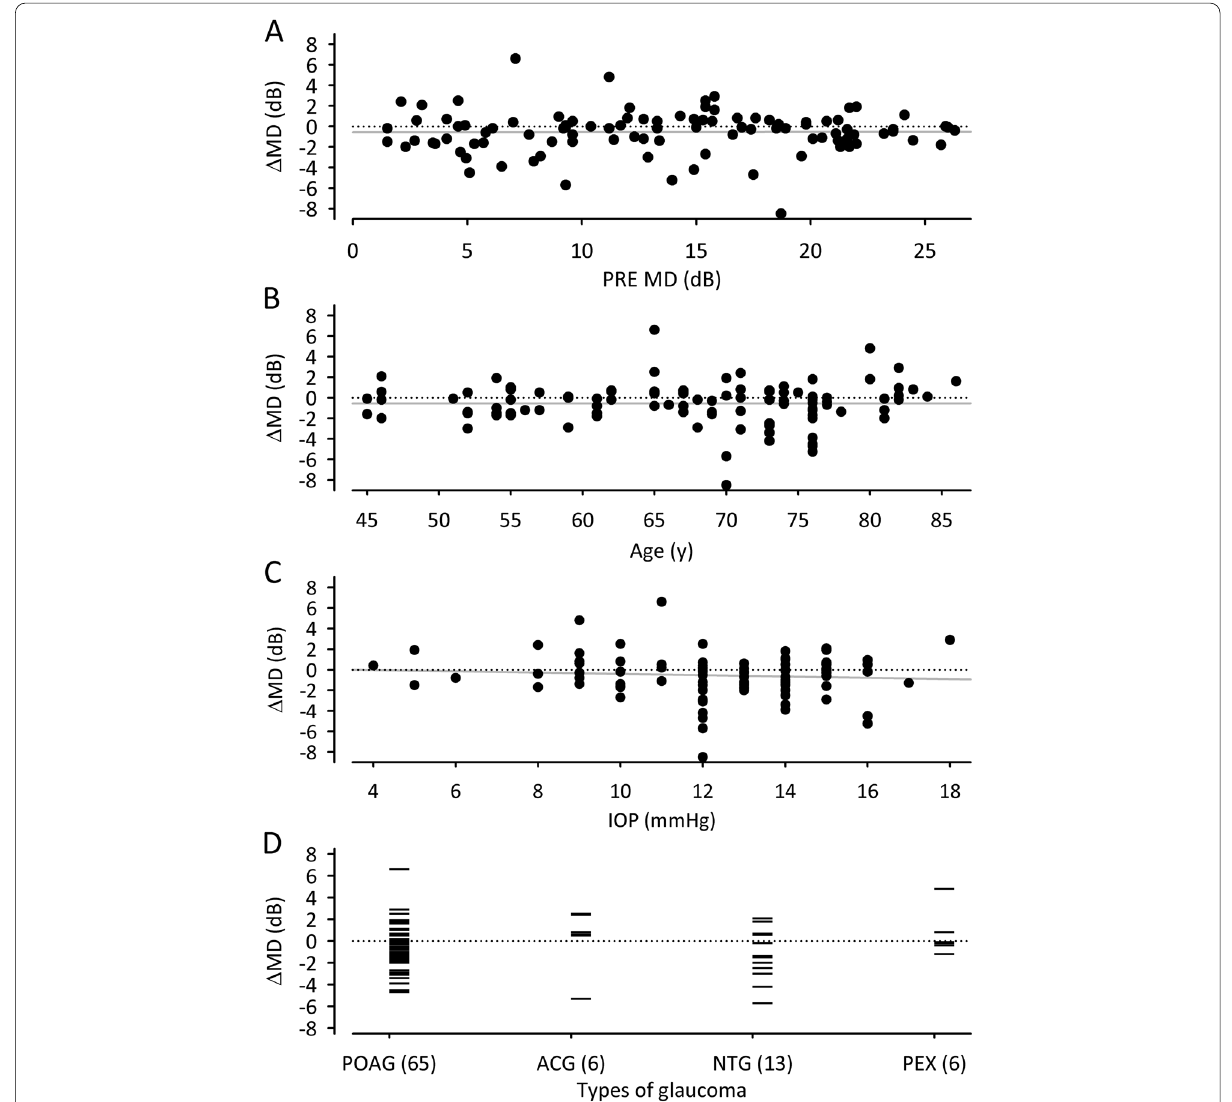
Fig. 5 Scatter plots with linear regression analysis of PRE MD versus ΔMD ( A ), patients’ age versus ΔMD ( B ), and IOP versus ΔMD ( C ). Regression lines are given in gray. Vertical point plots of ΔMD in the four main types of glaucoma ( D ). Numbers of eyes in each group are presented in brackets. Primary open-angle glaucoma (POAG), angle-closure glaucoma (ACG). normal tension glaucoma (NTG), pseudoexfoliative glaucoma